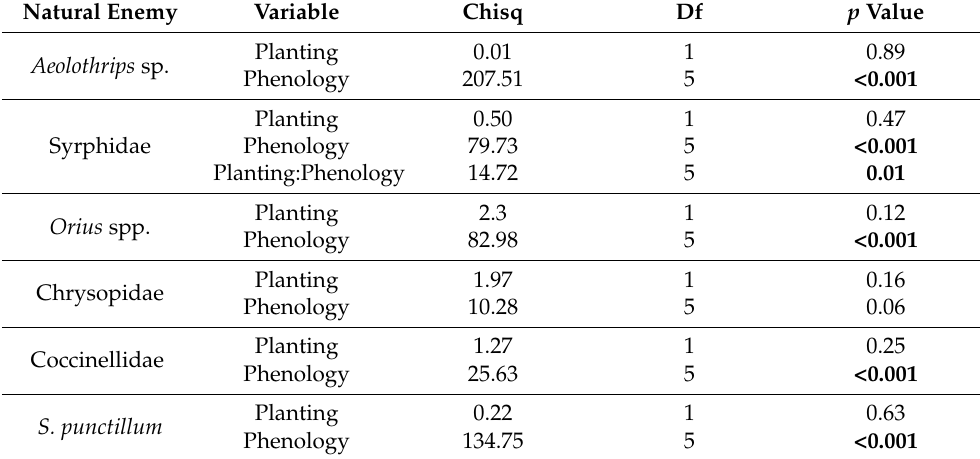
Table 2. Results of the generalized linear mixed models of NE abundance according to the maize phenology and planting period (early and late) and their interaction for all years. Natural Enemy